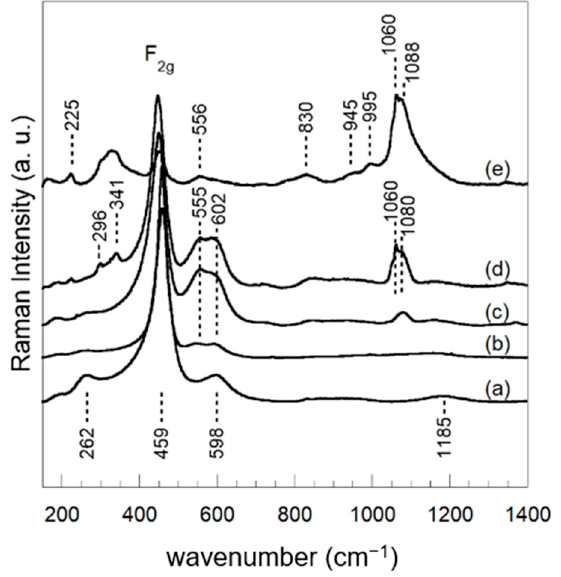
Figure 3. Raman spectra of the prepared oxide catalysts, freshly calcined in air at 450 °C for 4 h: (a) CeO 2 ; (b) CeLa(75:25); (c) CeLa(50:50); (d) CeLa(25:75); (e) La 2 O 3 .